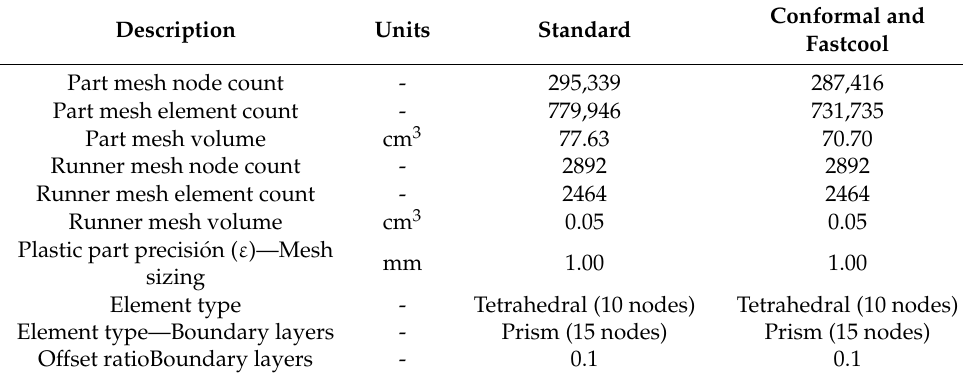
Table 3. Mesh statistics for the meshes analyzed in the present